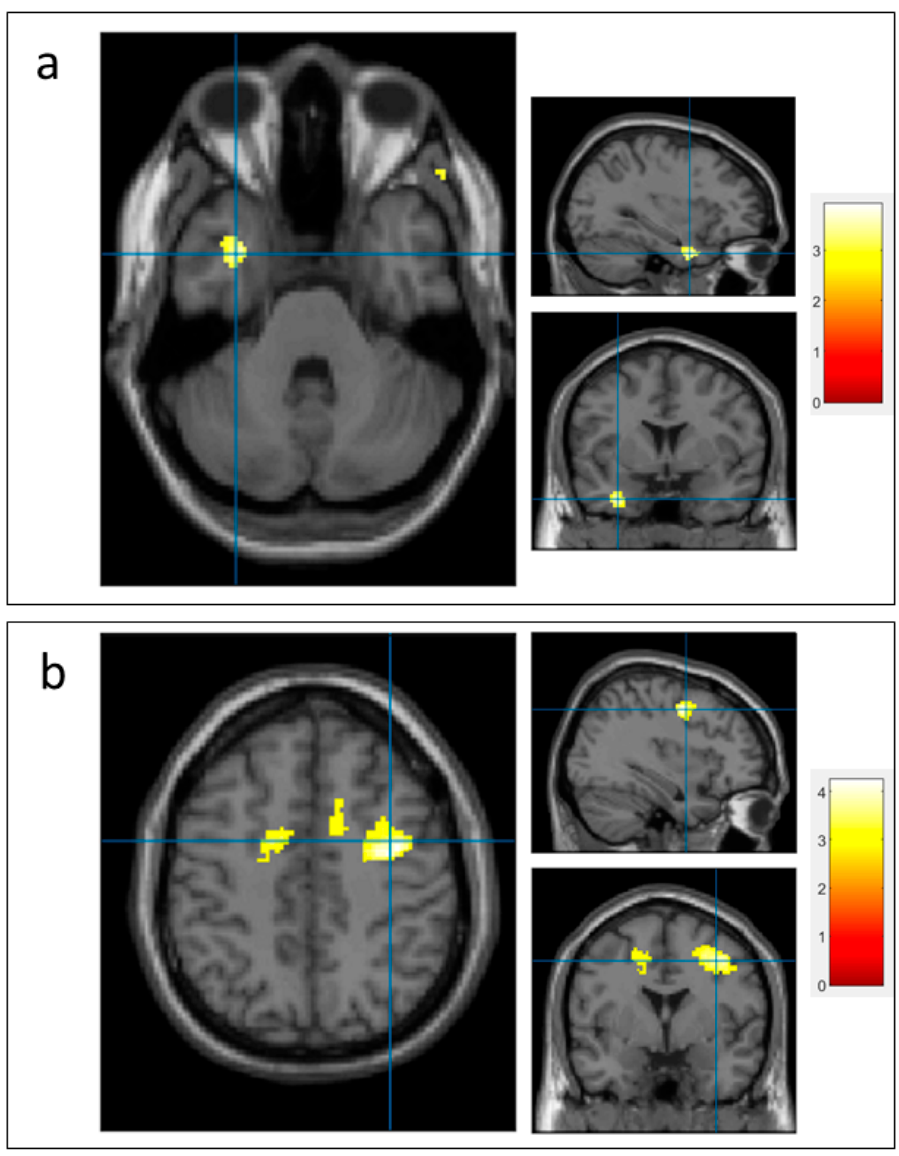
Figure 4. Functional MRI showing brain area activated during the acquaintance face recognition task, without device assistance ( a ) and with device assistance ( b ).